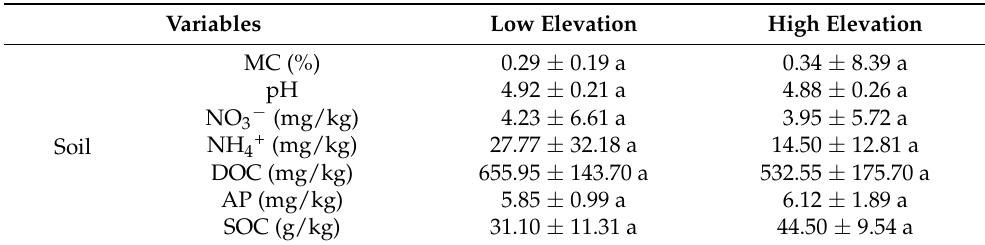
Table 2. Cumulative soil physiochemical properties and plant diversity indices at the low and high elevation evergreen broadleaf forests on Wuyi